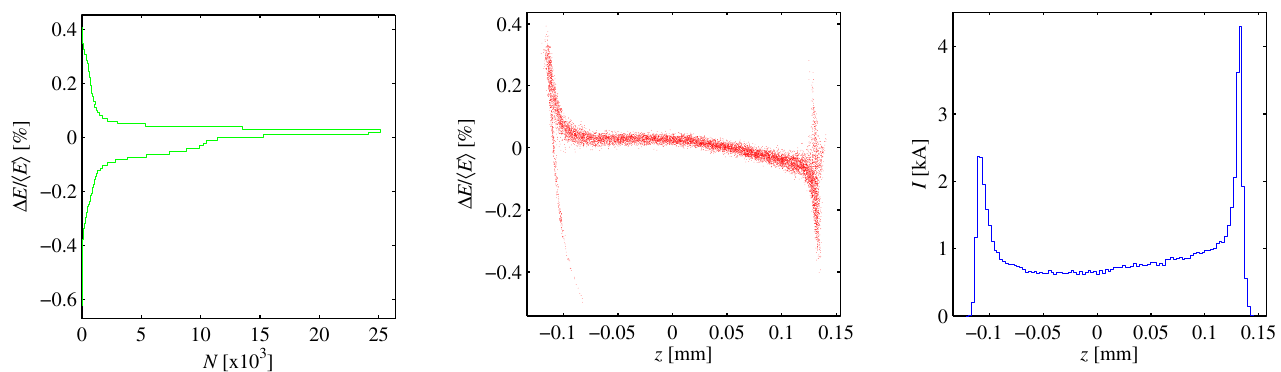
FIG. 14. (Color) Energy profile (left), longitudinal phase space (middle), and bunch current distribution (right) at the linac end when the combined option, passive and active linearizer, is considered. For the passive linearizer the second characteristic wave is also considered. Bunch mean energy h E i ¼ 1076 MeV